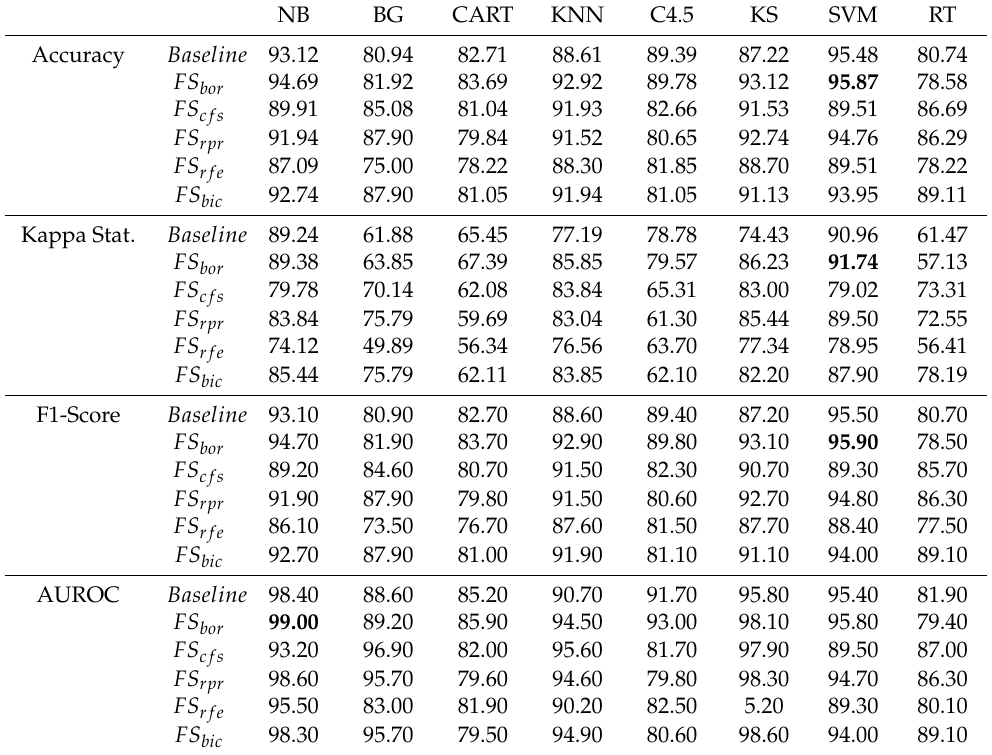
Table 7. Performance analysis of classifiers for baseline and its generated feature subsets of adolescents.